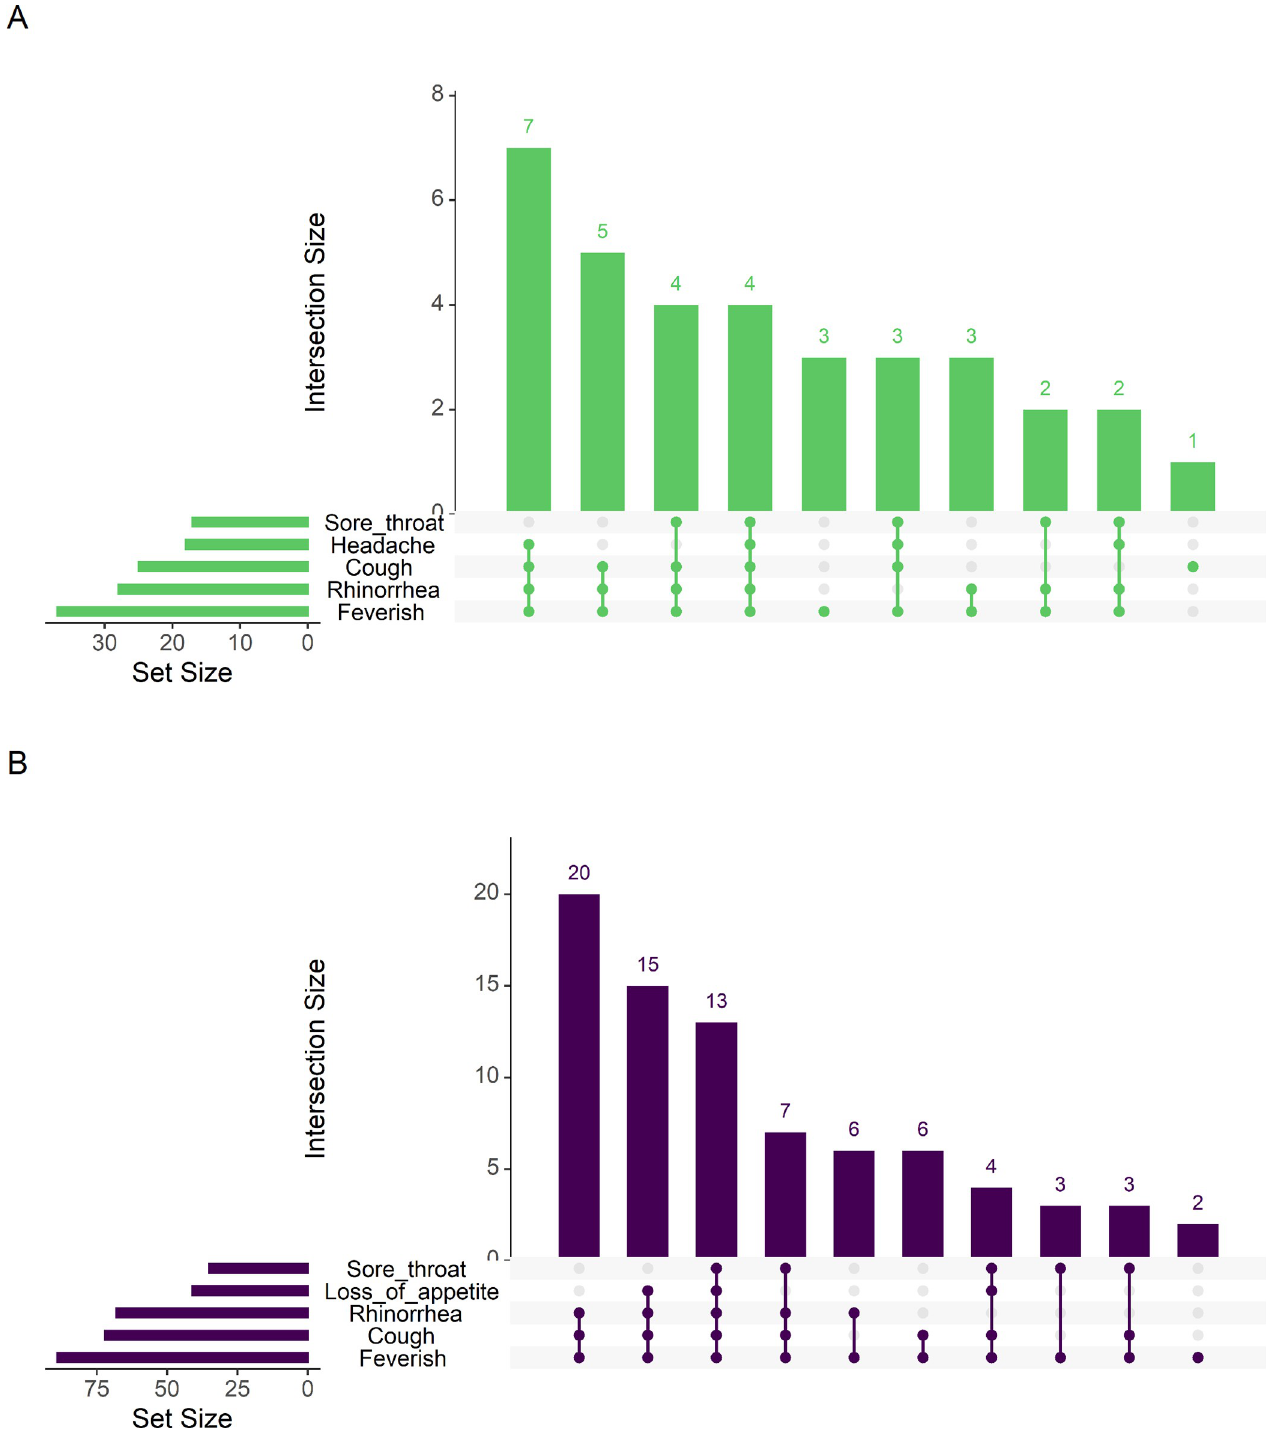
Fig 2. Comparison of common symptom groupings between symptomatic endemic HCoVs and SARS-CoV-2 infections. A: Upset plot of symptom groupings for symptomatic SARS-CoV-2 infections. B. Upset plot of symptom groupings for symptomatic endemic HCoV infections.